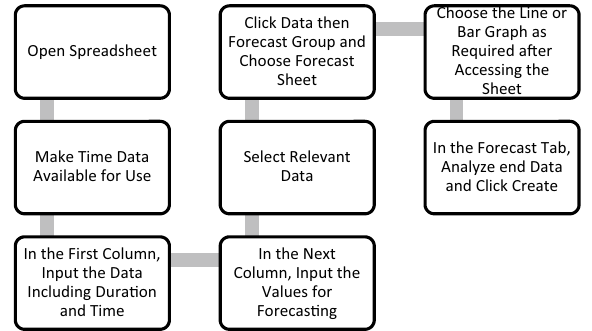
Figure 3. Flowchart to estimate outcomes by time series